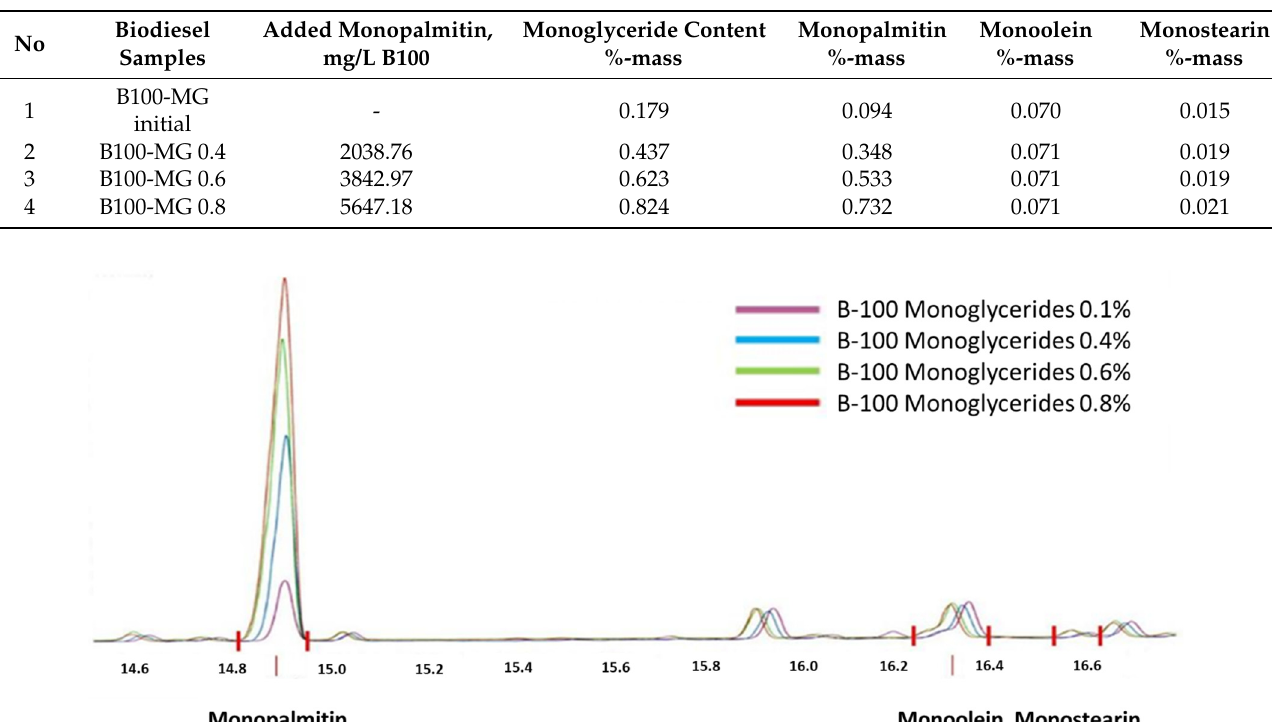
Table 3. Monoglyceride content variation in biodiesel samples.